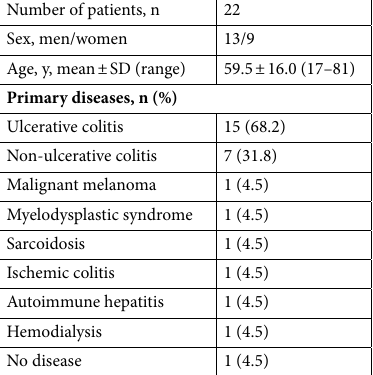
Table 2. Enrolled patients and their primary diseases.